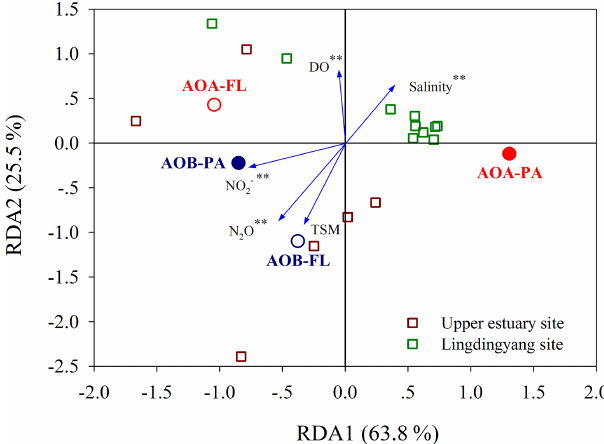
Figure 4. The redundancy analysis of the relative abundance of AOA amoA and AOB amoA under biogeochemical